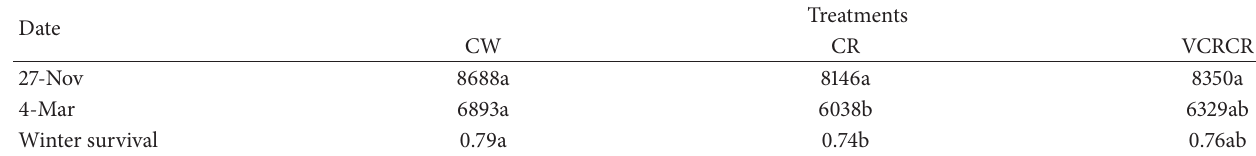
Means in the same rows followed by the same letter are not significantly